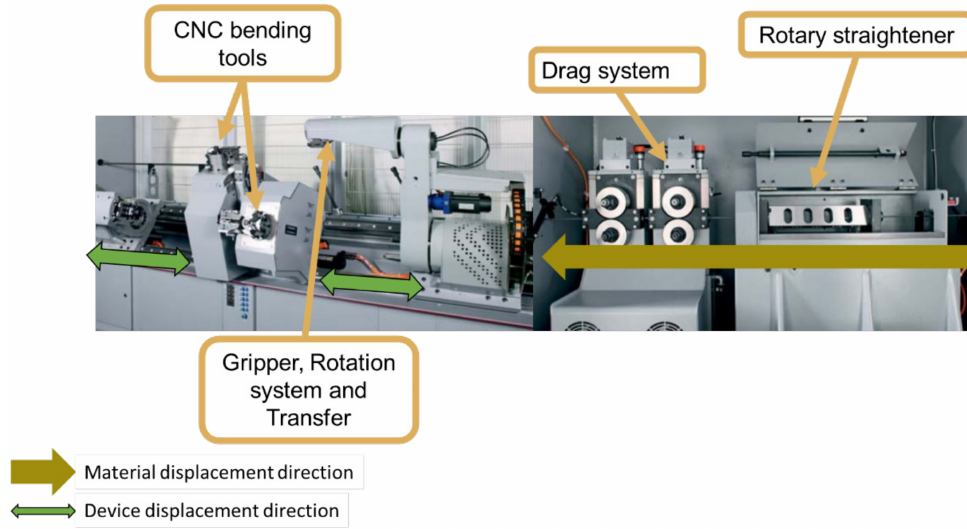
Figure 11. Details of the BT5.2